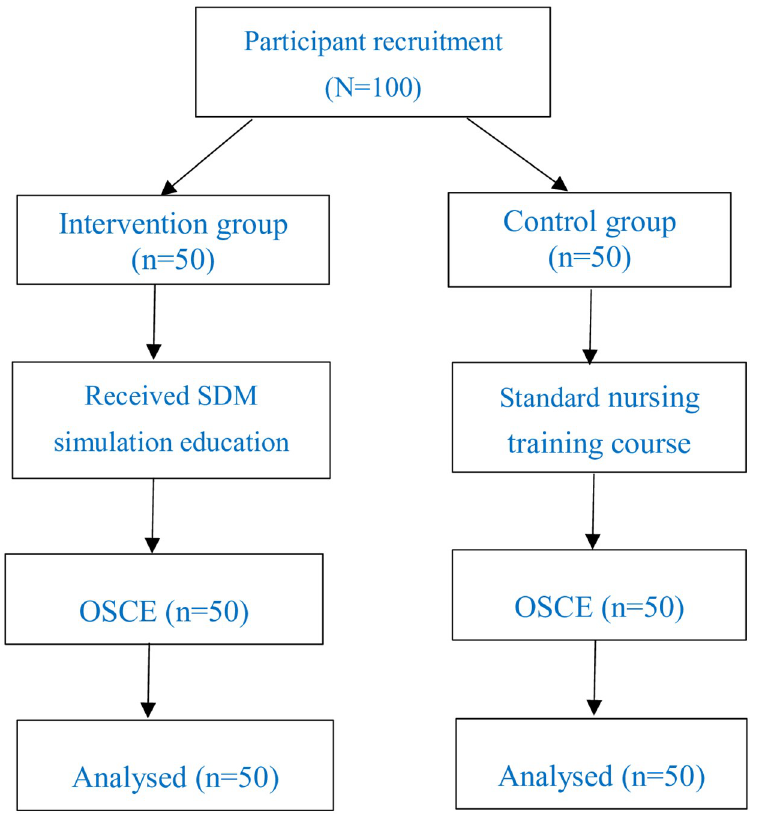
Fig 1. The study flow